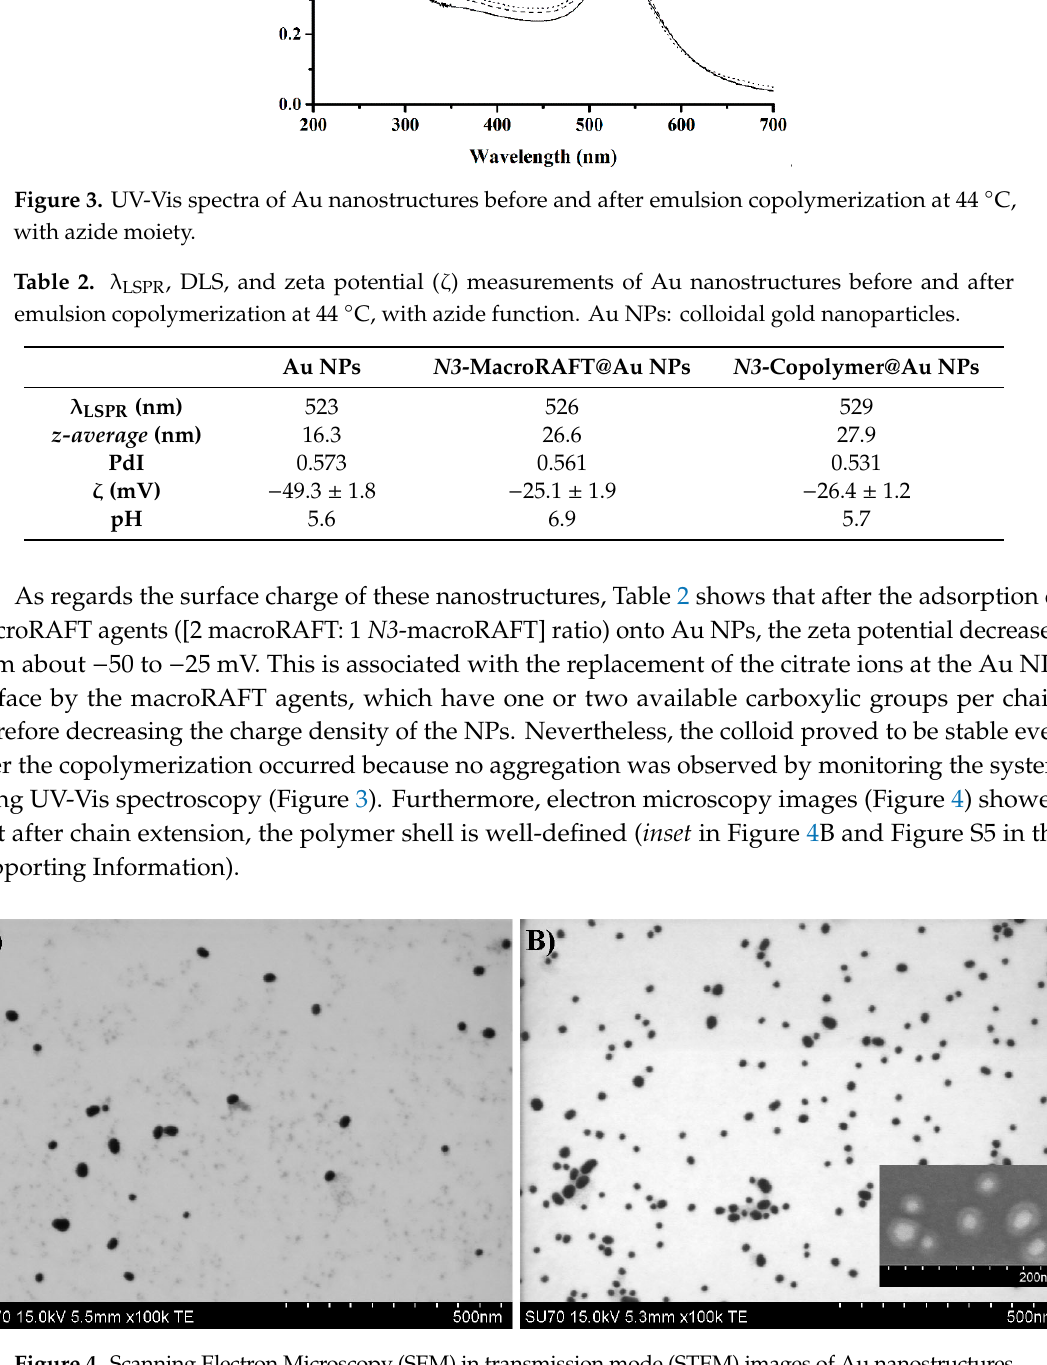
Figure 4. Scanning Electron Microscopy (SEM) in transmission mode (STEM) images of Au nanostructures prepared with the mixture 2macroRAFT:1 N3 -macroRAFT agents ( A ) before and ( B ) after emulsion copolymerization. ( B - inset ) secondary electron imaging showing in detail the core– shell nanostructure.